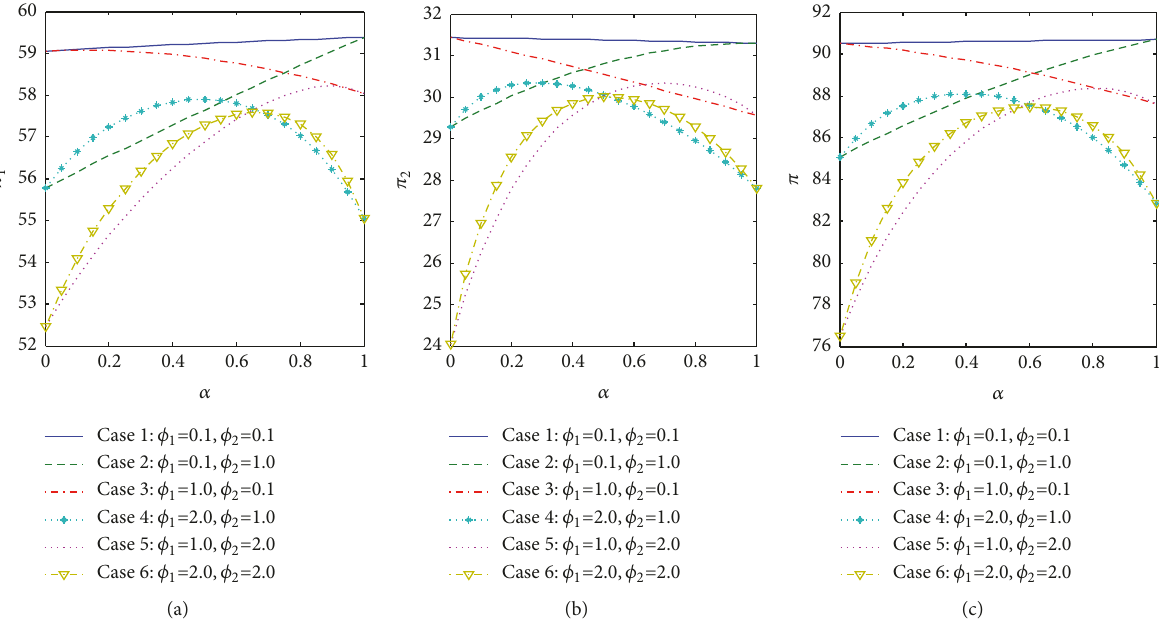
Figure 2: The impact of bargaining power 𝛼 on the expected